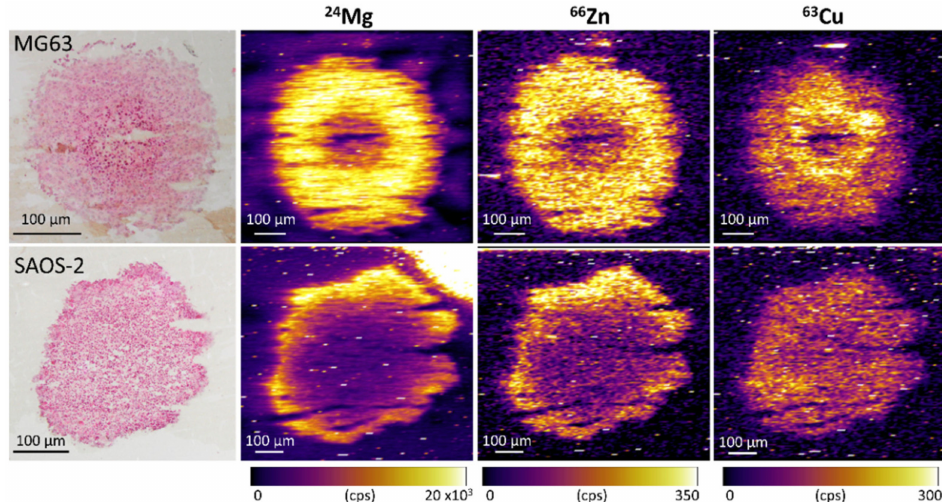
Figure 13. Elemental compositions within the OS aggregoid models identified the tumour microenvironment regions. H&E stain of serial sections of same aggregoid models imaged during LA-ICP-MSI analysis. Scale bar: 100 µ m. Elemental maps of 24 Mg, 66 Zn and 63